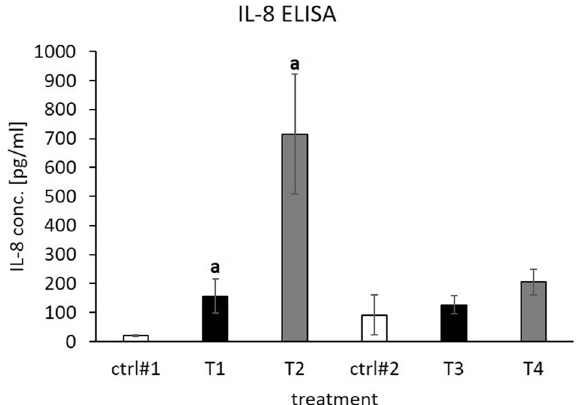
Figure 7. IL8 ELISA with supernatants of THP-1 cells incubated with SGBS-CM. THP-1 cells were incubated for 4 days with RPMI:SGBS-CM (1:1) from d4 [containing DMSO (T1) or DEHP (T2)] and d8 [previously treated with DMSO (T3) or DEHP (T4)] of adipogenesis. The corresponding controls were ctrl#1: RPMI + unconditioned induction medium from d4 (1:1) and ctrl#2: RPMI + unconditioned differentiation medium from d8 (1:1). Samples of the cell supernatant were taken at d7 of differentiation. An IL8 ELISA was performed using the absolute level of both cytokines. The data were statistically analyzed by one-way ANOVA on ranks with the Student–Newman–Keuls method. N = 4, n = 1 (4 pooled wells); a p < 0.05; ctrl#1 vs. T1 or